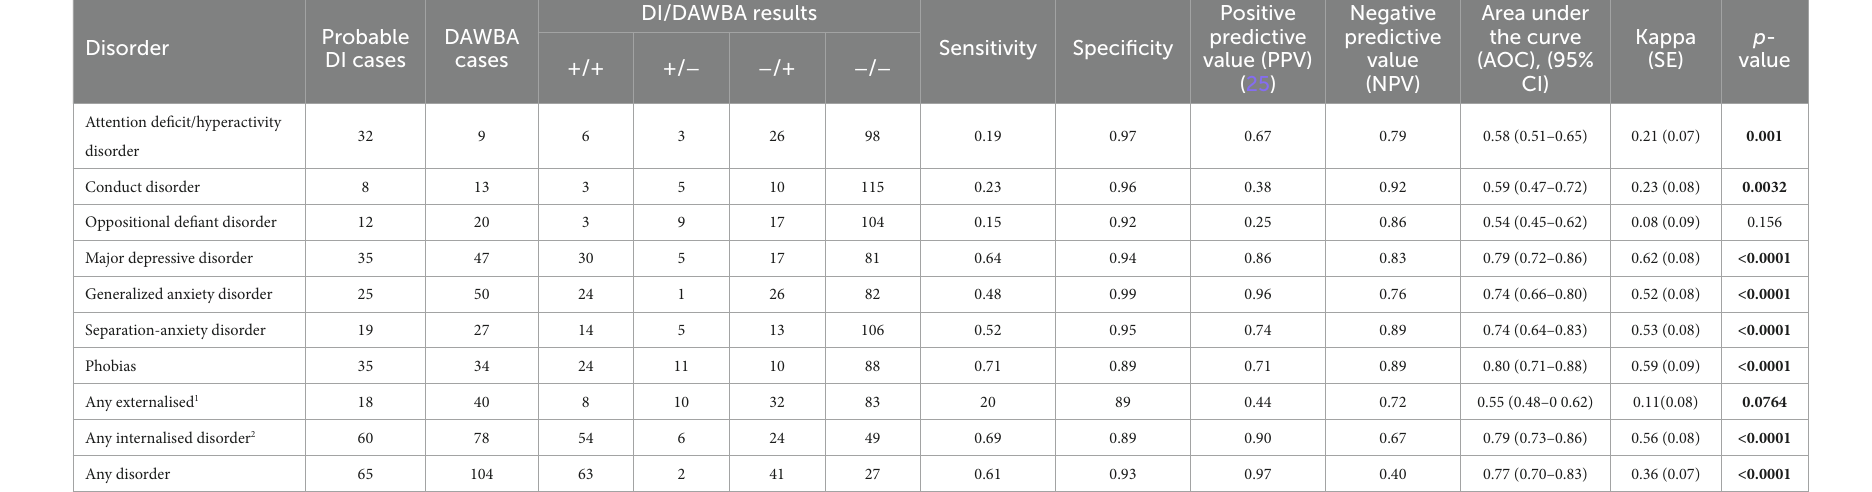
TABLE 1 Comparison of the diagnostic results of the self-report Dominic Interactive (DI) video game (probable cases) to that of the diagnostic result of the clinician-administered Development and Well-Being Assessment (DAWBA) in 133 children in Tianjin, China.